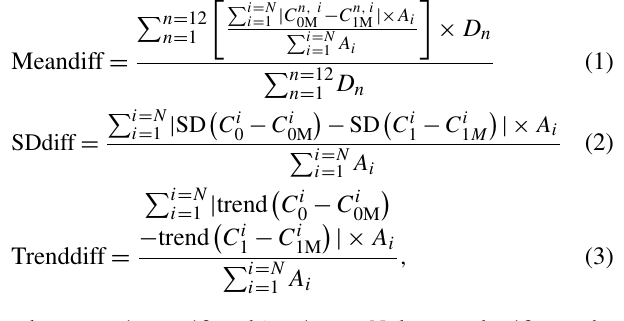
olution grid using a k d-tree ( k -dimensional, Bentley, 1975) nearest-neighbor interpolation method provided by a